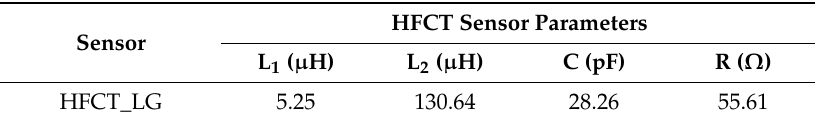
Figure 2. High-frequency current transformer (HFCT) enclosure and detailed inner view. Table 1. HFCT_LG sensor parameters.